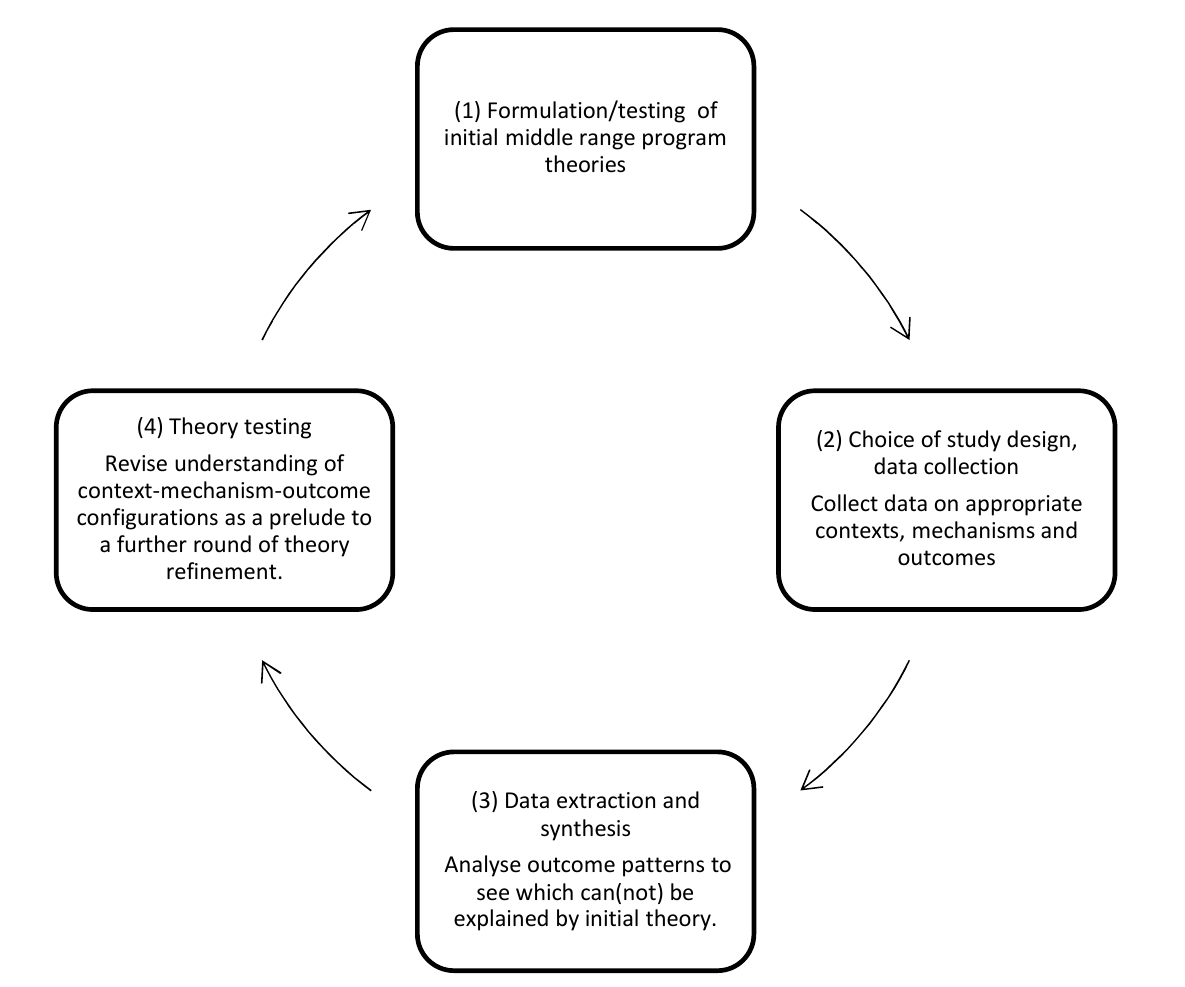
Figure 1. Realist cycle; adapted from Pawson [30] and van Belle et al. [37].